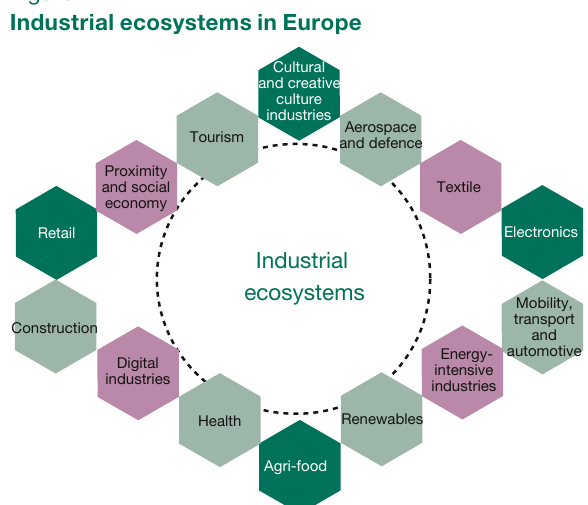
Source: European Commission